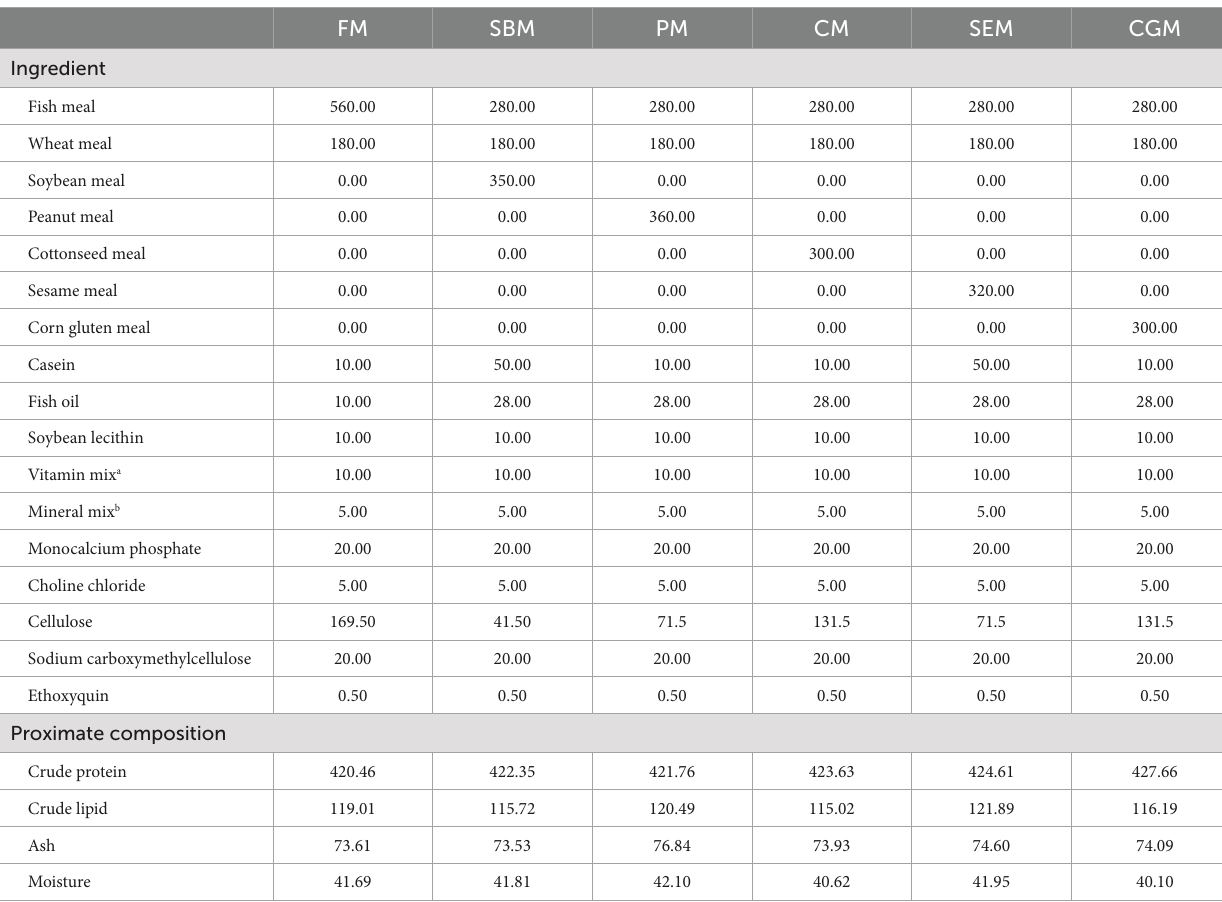
TABLE 1 Formulation of the experimental diets (g/kg dry matter